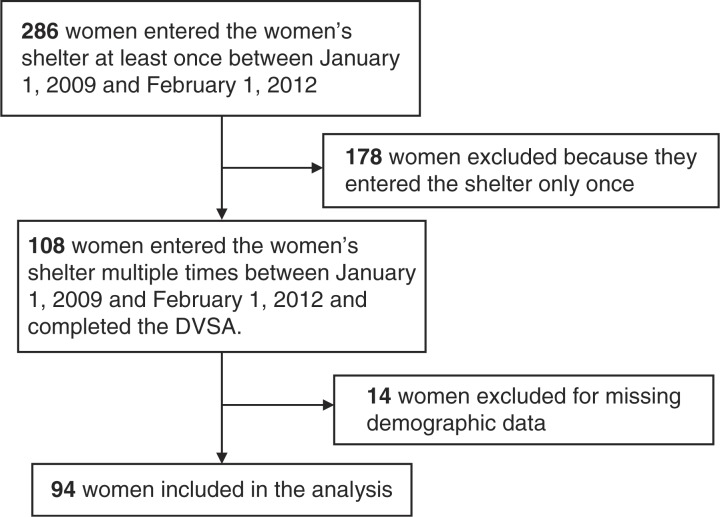
Study flow diagram.